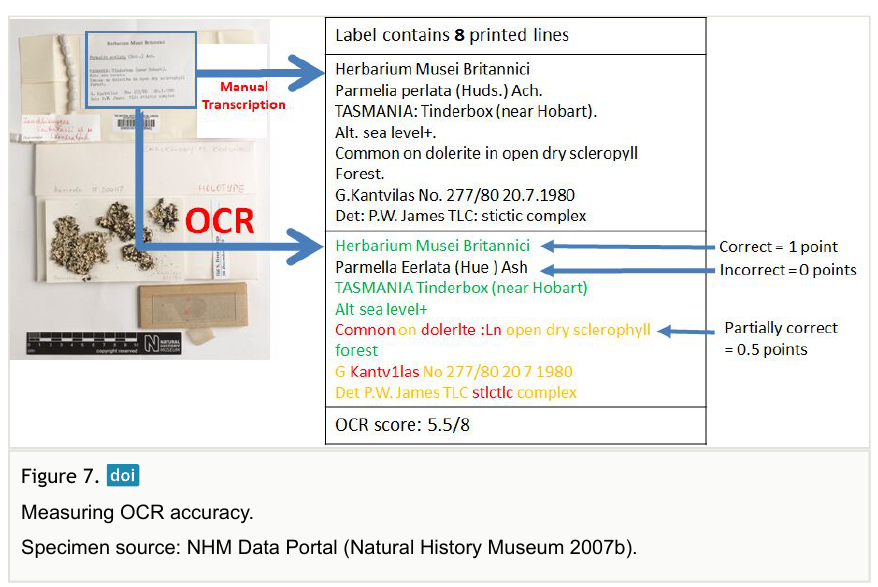
Figure 7. Measuring OCR accuracy.